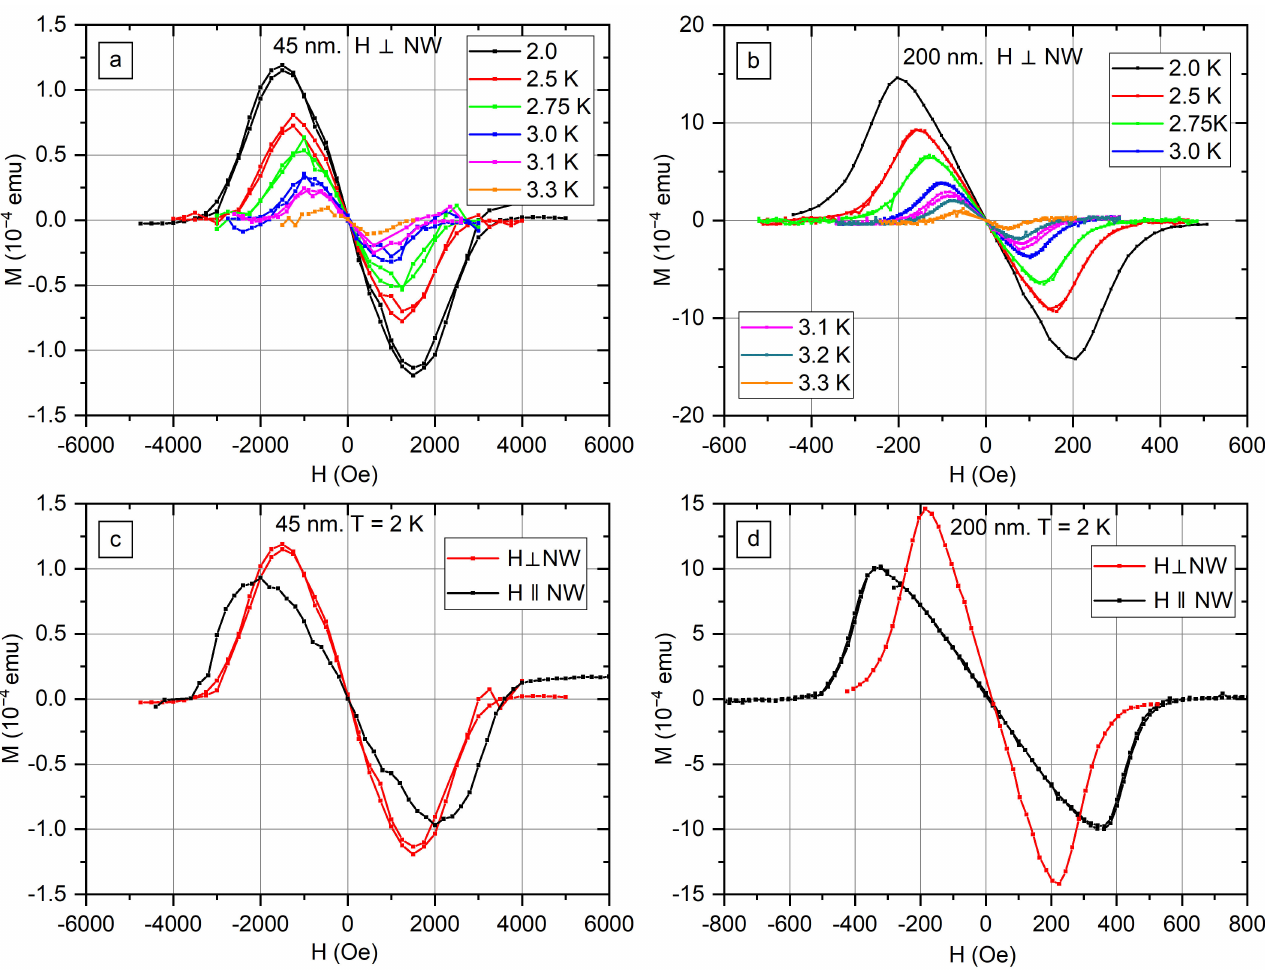
Figure 5. The magnetic moment M as a function of transverse magnetic field H for In nanowire arrays with nanowire diameters 45 nm ( a ) and 200 nm ( b ). The comparison of M ( H ) curves measured at 2 K temperature for the same sample in transvers and axial fields: s45 ( c ) and s200 ( d